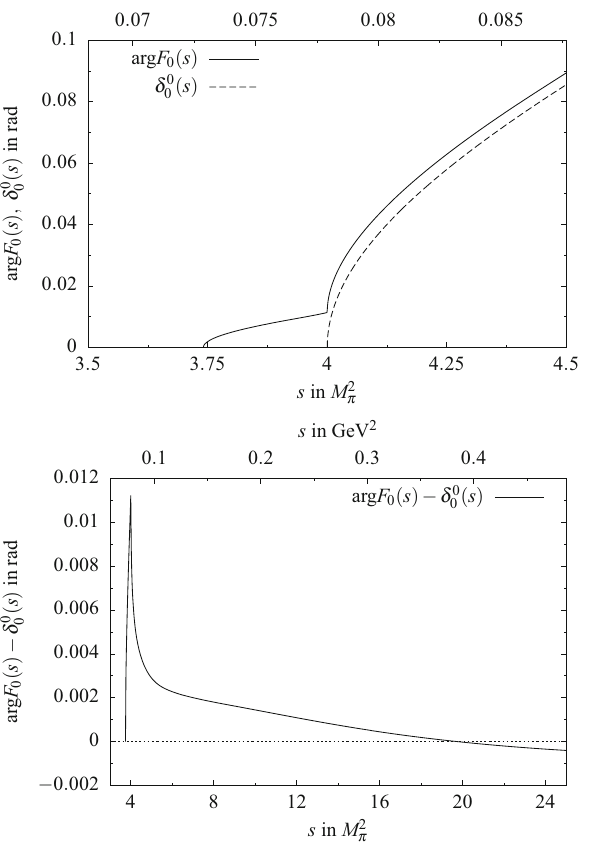
Fig. 10 Toppanel comparisonofarg F 0 ( s ) ( solidline ),thephaseofthe neutral-pion scalar form factor including the effects of different π 0 π 0 ( s ) ( dashed and π + π − thresholds, to the isospin-symmetric phase δ 0 0 ( s ) over a larger range in line ). Bottom panel arg F 0 ( s ) − δ 0 0